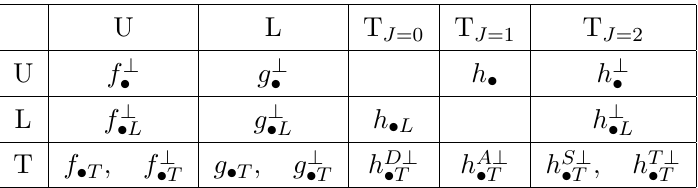
Quark TMD distributions of twist-three sorted with respect to polarization properties of both the operator (columns) and the hadron (rows). The labels U, H, and T are for the